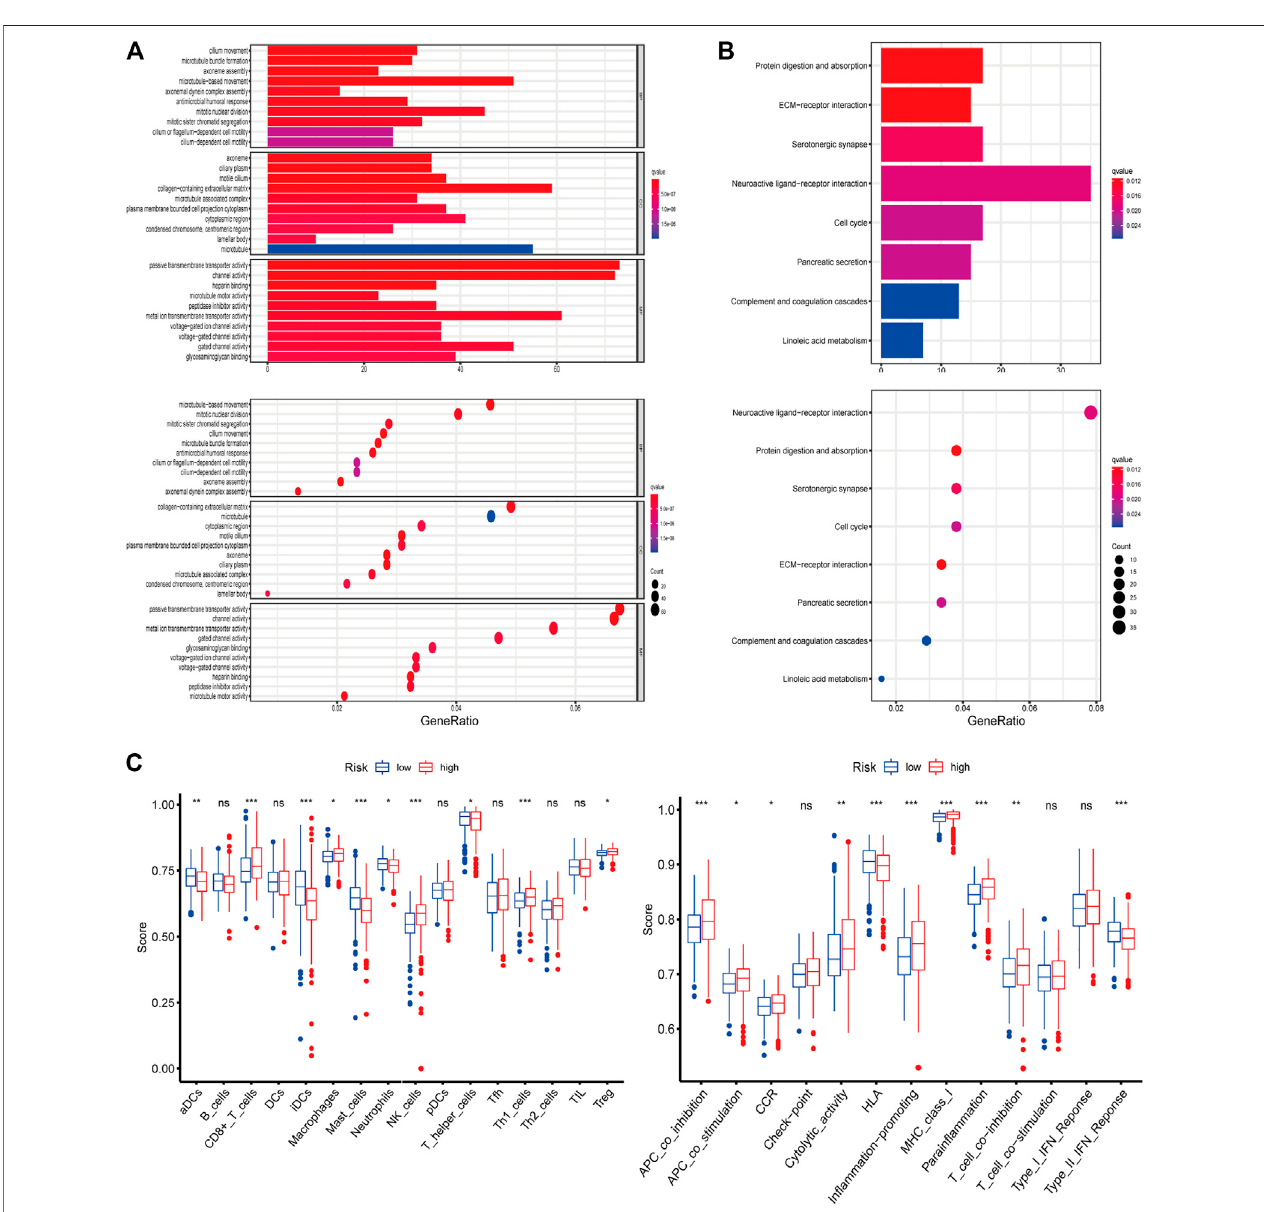
FIGURE 4 | (A – B) Representative results of GO and KEGG of the ferroptosis-related genes signature. (C) Results of ssGSEA analysis.